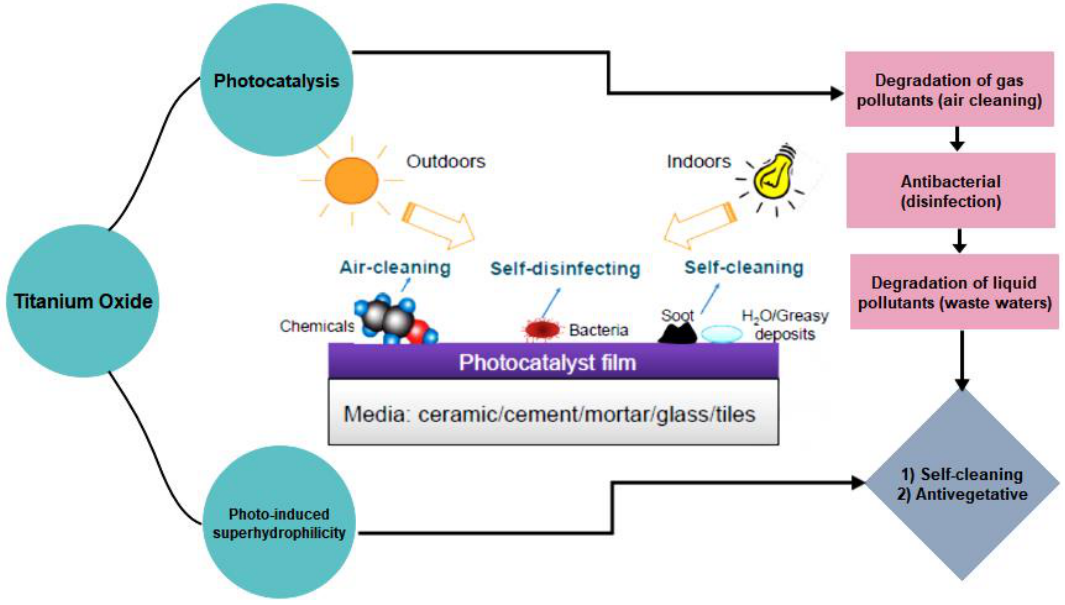
Figure 4. Main applications of the photocatalytic activity of TiO 2 as appearing in the literature [4]. Photo from [40].